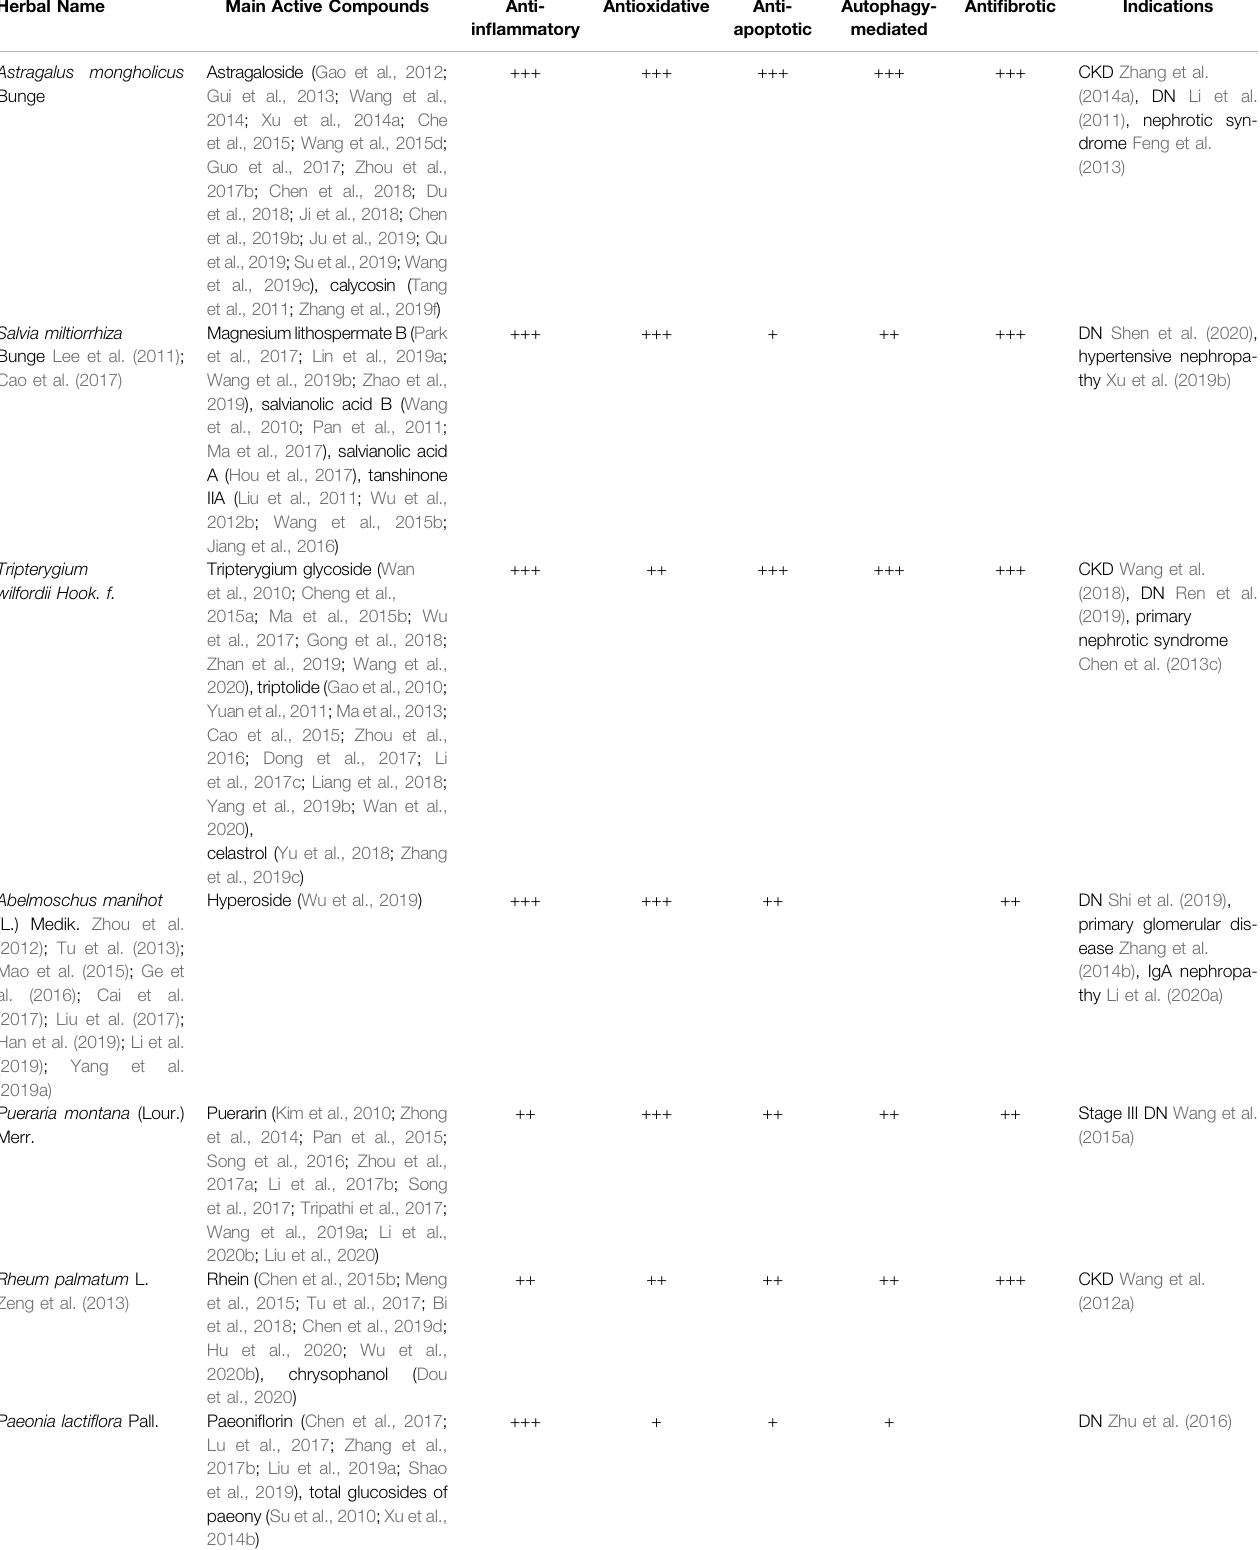
TABLE 1 | Summary of the mechanism of commonly used